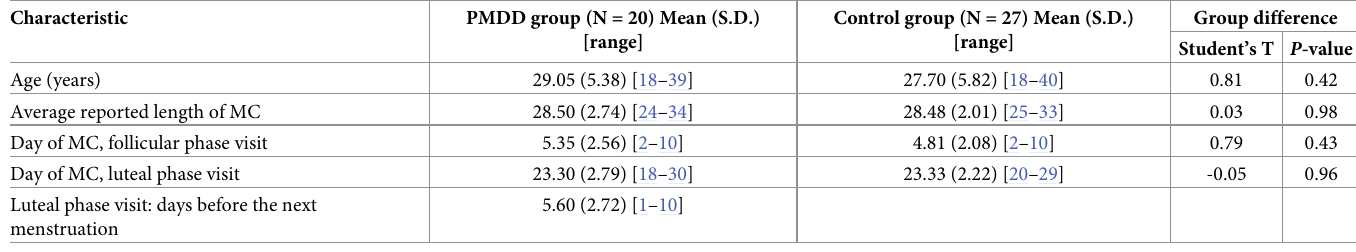
Table 1. Characteristics of the experimental